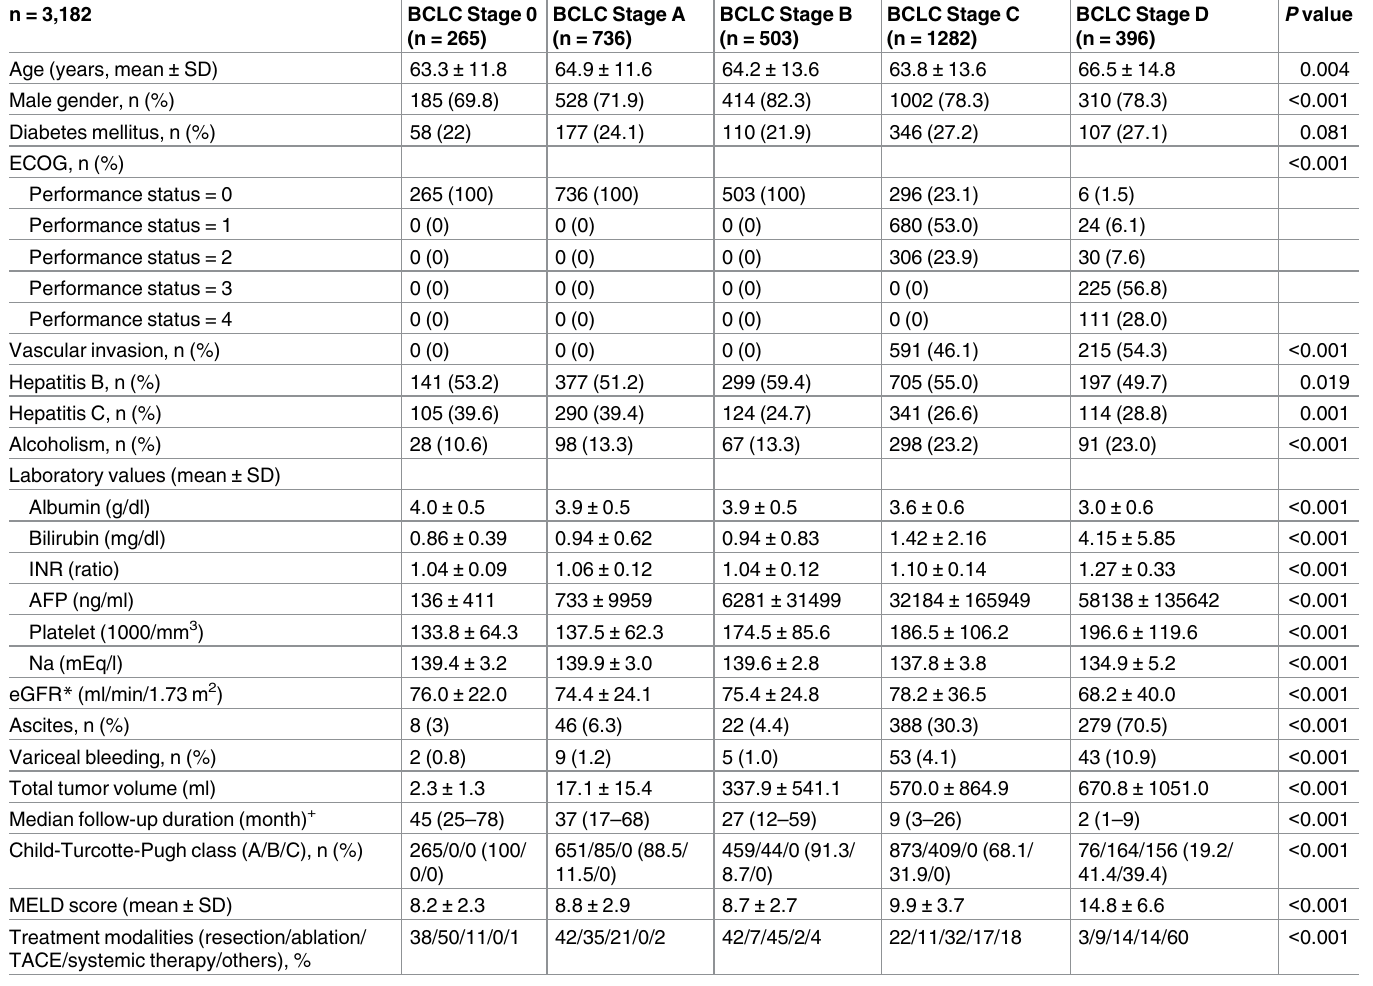
Table 1. Demographic, clinical, and staging information of the entire hepatocellular carcinoma cohort.